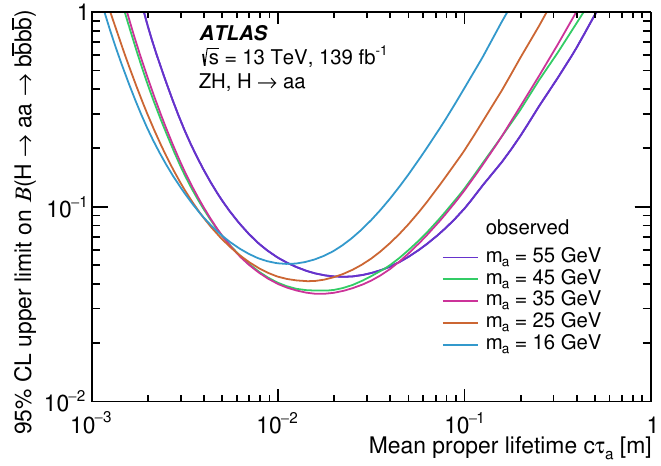
Figure 6 . Observed 95% CL exclusion limits on B ( H → aa → b ¯ bb ¯ b ) as a function of cτ a .